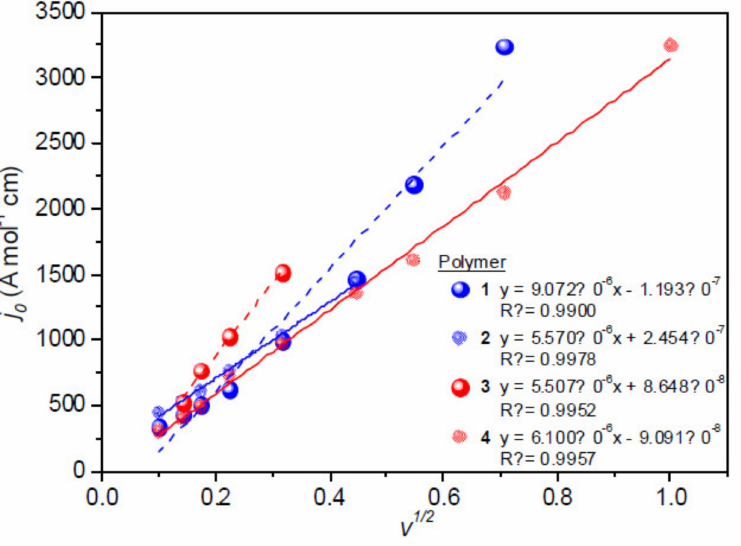
Figure 9. Variation of normalized cathodic current densities with the square root of scan